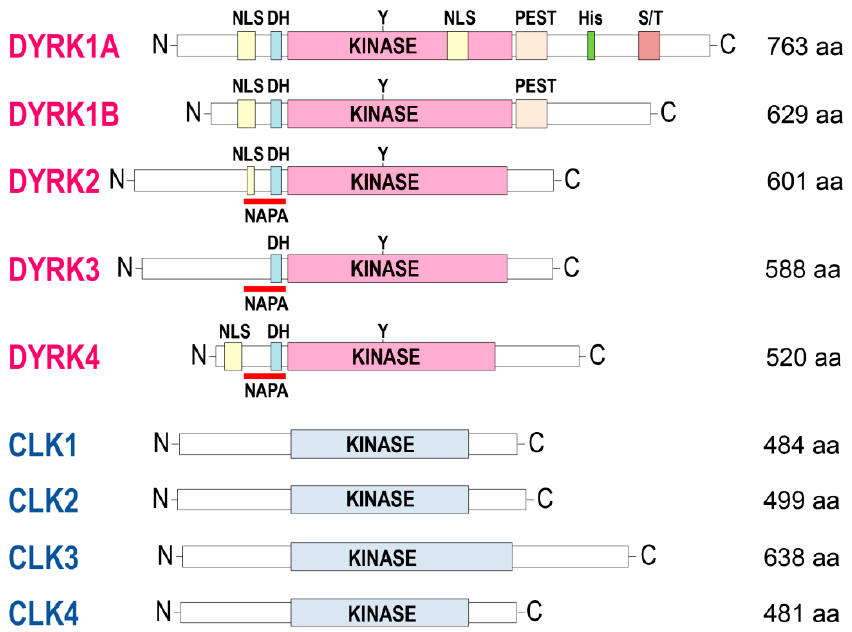
Figure 3. Comparison of DYRKs and CLKs overall structures. Schematic representation of the canonical protein sequences of human CLKs and DYRKs (extracted from uniprot.org). NB: a NLS in DYRK4 is only found in isoform 4, the canonical sequence being isoform 5. aa, amino acids; C, C-terminal; DH, DYRK homology box; His, His domain (13 consecutive histidine residues region); KINASE, kinase domain; N, N-terminal; NAPA, N-terminal autophosphorylation accessory domain; NLS, nuclear localization signals domain; PEST, proline (P), glutamic acid (E), serine (S), and threonine (T)-rich domain; S/T, serine, and threonine-enriched domain; Y, Tyrosine residue autophosphorylated by DYRKs within the activation loop.